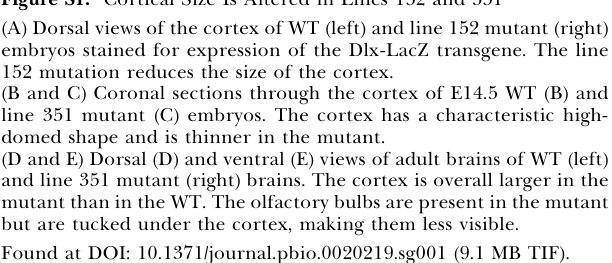
Figure S1. Cortical Size Is Altered in Lines 152 and 351 (A) Dorsal views of the cortex of WT (left) and line 152 mutant (right) embryos stained for expression of the Dlx-LacZ transgene. The line 152 mutation reduces the size of the cortex. (B and C) Coronal sections through the cortex of E14.5 WT (B) and line 351 mutant (C) embryos. The cortex has a characteristic high- domed shape and is thinner in the mutant. (D and E) Dorsal (D) and ventral (E) views of adult brains of WT (left) and line 351 mutant (right) brains. The cortex is overall larger in the mutant than in the WT. The olfactory bulbs are present in the mutant but are tucked under the cortex, making them less visible. Found at DOI: 10.1371/journal.pbio.0020219.sg001 (9.1 MB TIF). Figure S2. Central Nervous System Defects and Cleft Upper Jaw in Lines 366 and 357 (A) Lateral view of an E14.5 WT embryo. (B) The cleft upper jaw of a line 366 mutant is visible at the left. The telencephalon, including the cortex, is significantly shortened along the rostrocaudal axis. (C and D) Lateral and front views of the cleft and reduced upper jaw of an E18.5 embryo homozygous for the line 366 mutation. (E and F) Lateral views of WT (E) and line 357 homozygote (F) embryos at E13.5 showing the reduced telencephalon and relatively expanded midbrain. (G) A front view of the embryo in (F) shows the cleft upper jaw. (H and I) Sagittal sections through E13.5 WT (H) and line 357 (I) embryos. The overgrown midbrain in the mutant embryo has forced the neuroepithelium into folds. Found at DOI: 10.1371/journal.pbio.0020219.sg002 (9.9 MB TIF). Figure S3. Line 407 Mutants Have Dorsoventral Defects in the Cortical Primordia and Facial Midline Defects (A) Lateral view of an E14.5 mutant embryo showing edema and hemorrhage suggestive of vascular defects. Frontal views of WT (B) and mutant (C) embryos illustrate the narrowed frontonasal process, maxilla, and mandible of the mutant. (D) shows coronal hemisections in a WT embryo. (E) shows the accumulation of Dlx-LacZ–positive cells in a SVZ-like area dorsal to the LGE. Found at DOI: 10.1371/journal.pbio.0020219.sg003 (4.3 MB